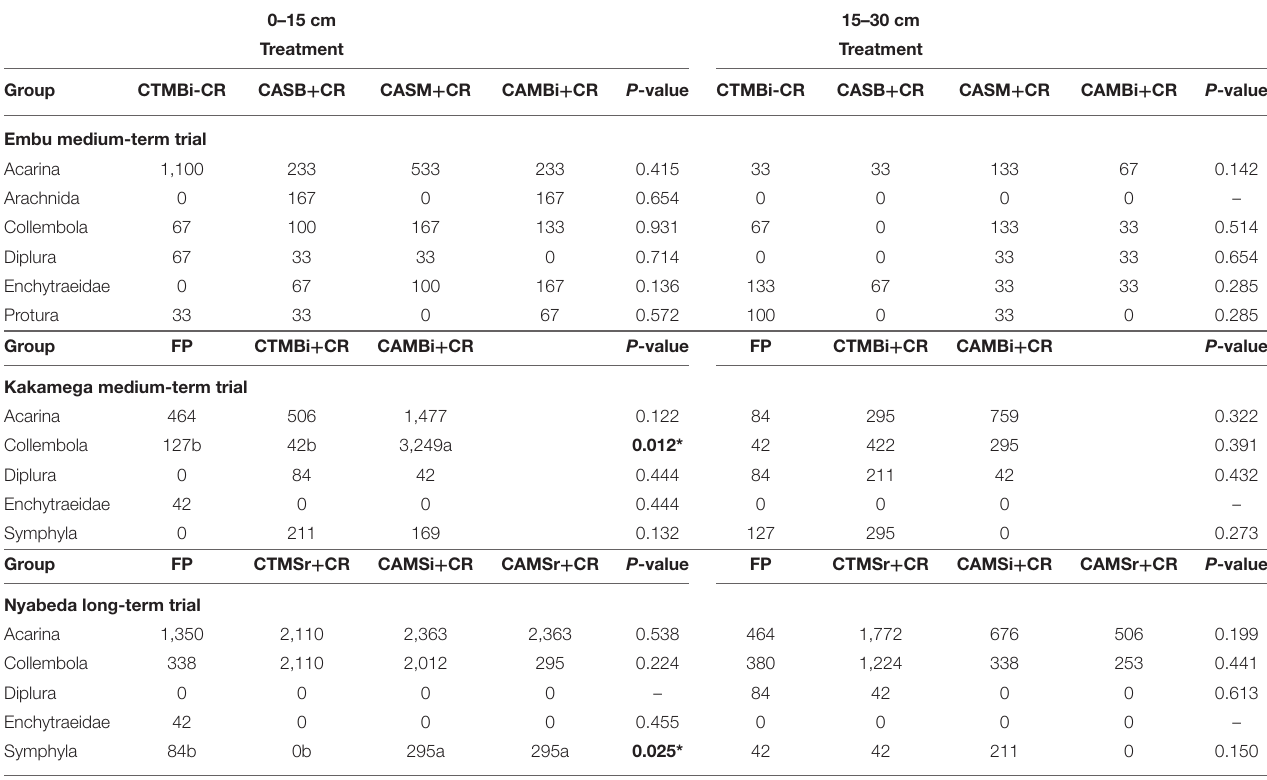
TABLE 5 | Mean abundance of soil mesofauna groups across treatments in long- and short-term trials of Embu, Nyabeda, and